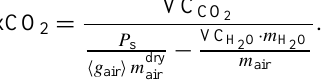
Figure 1. An example fit of the measured (black) with the calcu- lated (green) spectrum and their residuals (blue) for the various mi- crowindows used. Note the different signal-to-noise ratio due to dif- ferent instrument setup (see Sect.